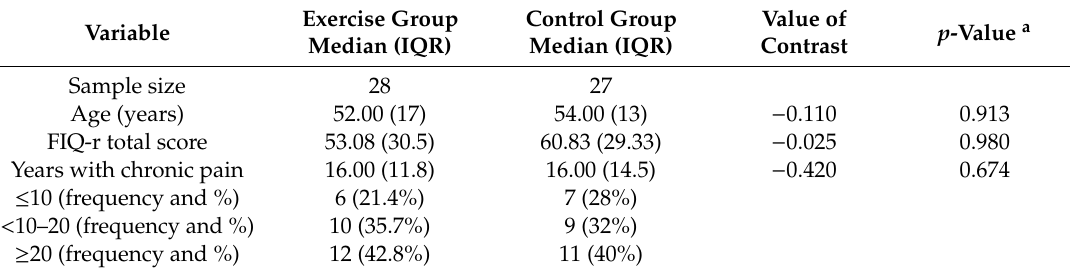
Table 1. Demographic data at baseline.